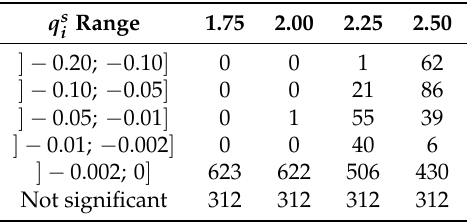
Table 4. The number of nodes for range of supply deficit as appear in Figures 5 and 8. Obviously, it can be done only for the PDA approach. The last line reports, for completeness, the number of nodes without water demand, i.e., with q s